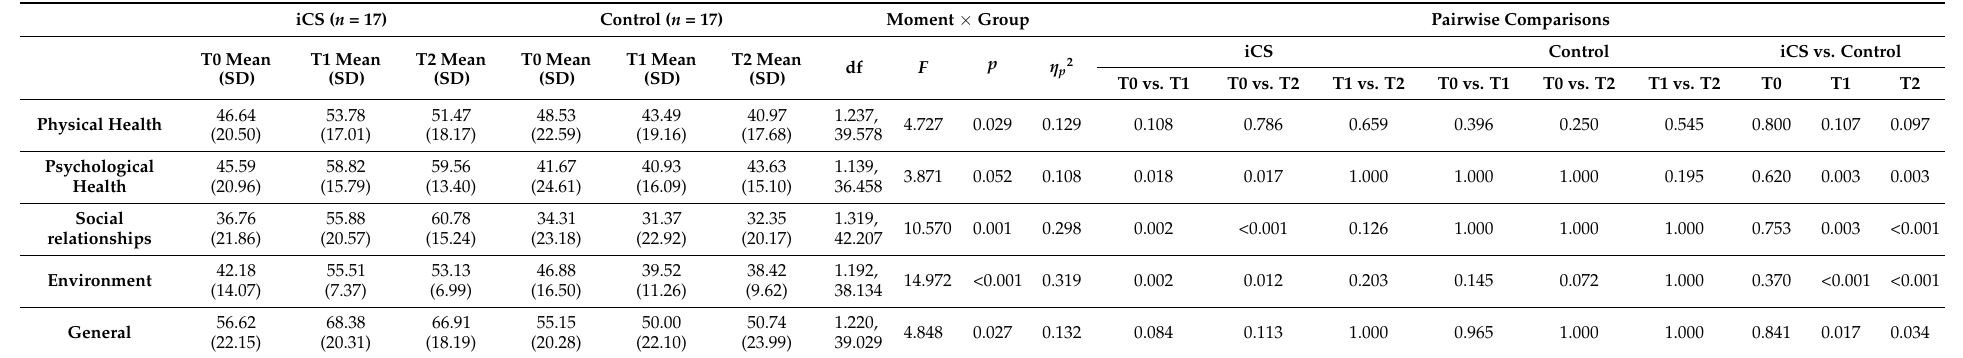
Table 3. Results of the repeated-measures ANOVA for the WHOQOL-Bref domain scores. The results of the pairwise comparisons (Bonferroni correction) are given for iCS vs. the control group at baseline (T0), endpoint (T1), and follow-up (T2) assessments, as well as the results of the pairwise comparisons (Bonferroni correction) for iCS and control groups (T0 vs. T1, T0 vs. T2, and T1 vs. T2). iCS ( n = 17)